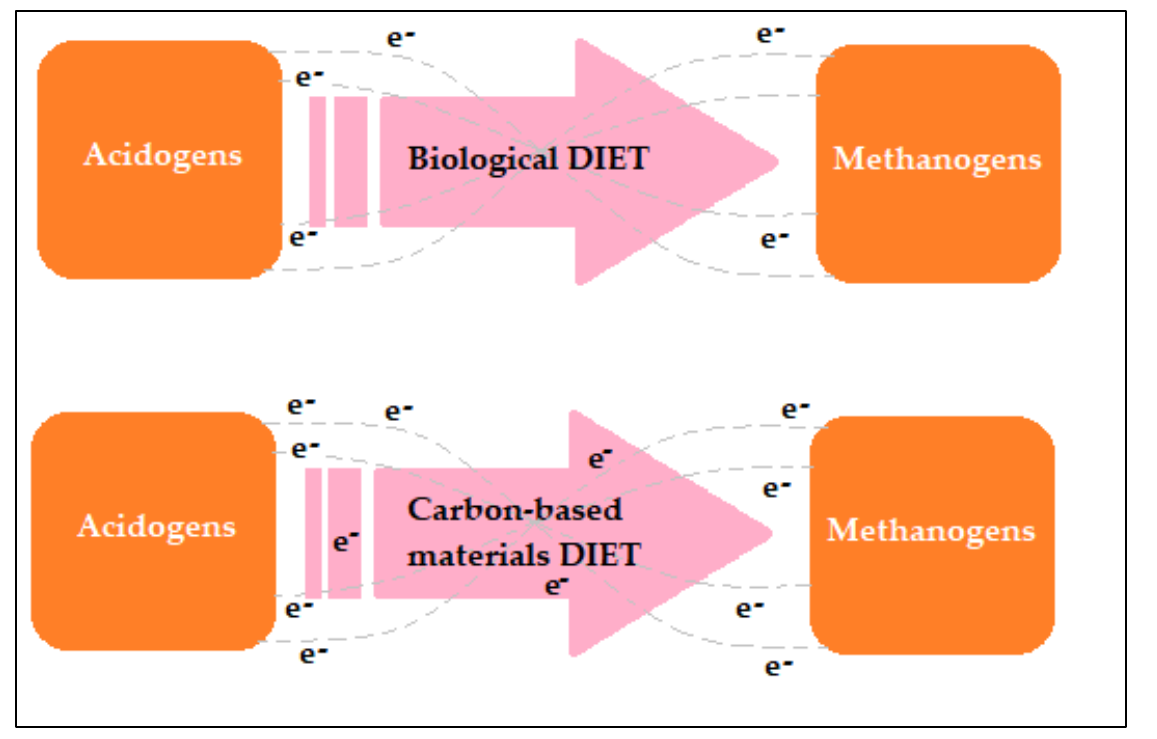
Figure 4. Biological and carbon-based direct interspecies electron transfer (DIET) methods. Adapted from [40].